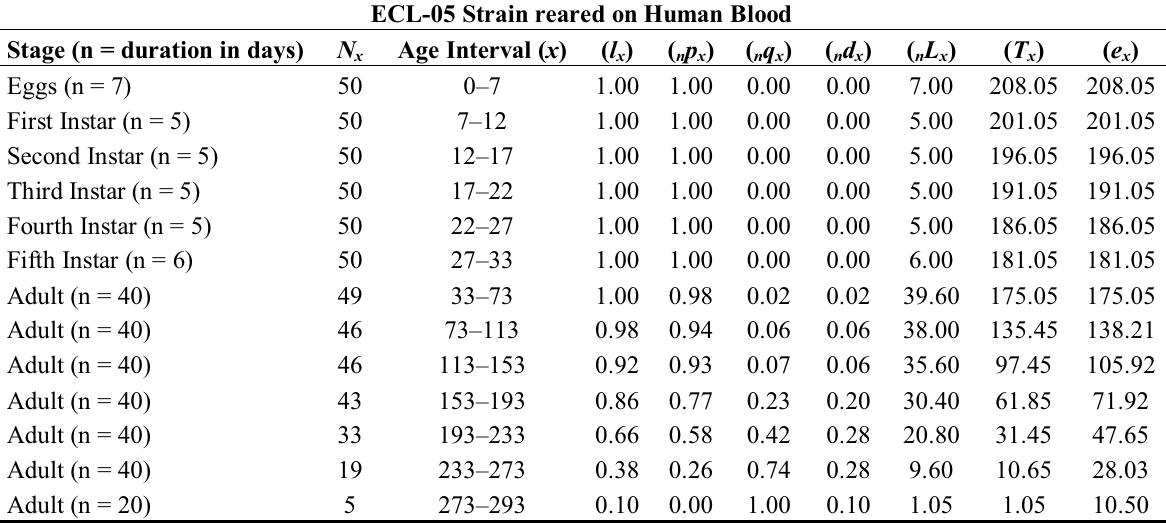
Table 2. Stage specific life table of (field strain) ECL-05 strain Cimex lectularius on human blood. ECL-05 Strain reared on Human